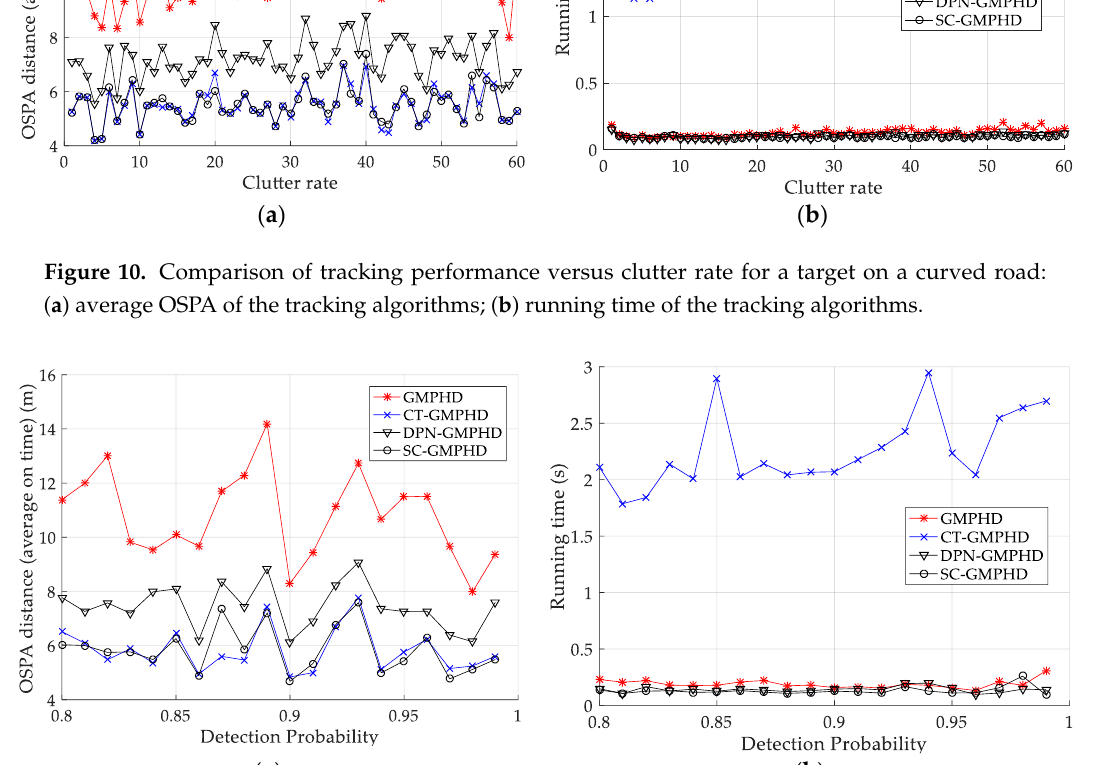
Figure 11. Tracking performance of the filters versus the detection probability for a target on a curved road: ( a ) average OSPA of the filters; ( b ) running time of the filters.